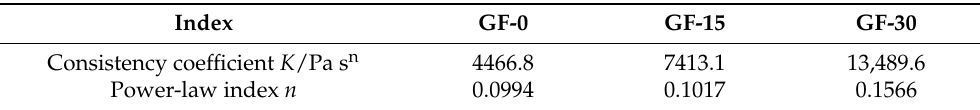
Figure 1. Rheological curves of gelled fuels containing different concentrations of Al nanoparticles. Table 1. The consistency coefficient and power-law index of gelled fuels containing different concentrations of nanoparticles.